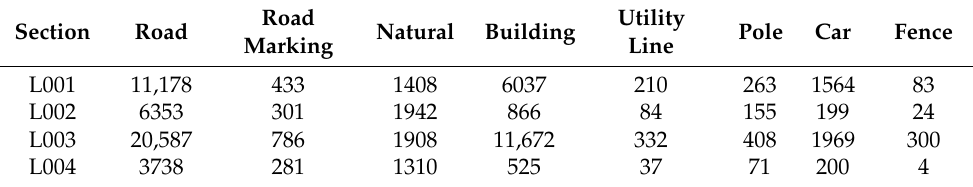
Table 2. Point counts of each category in each section of the Toronto3D dataset